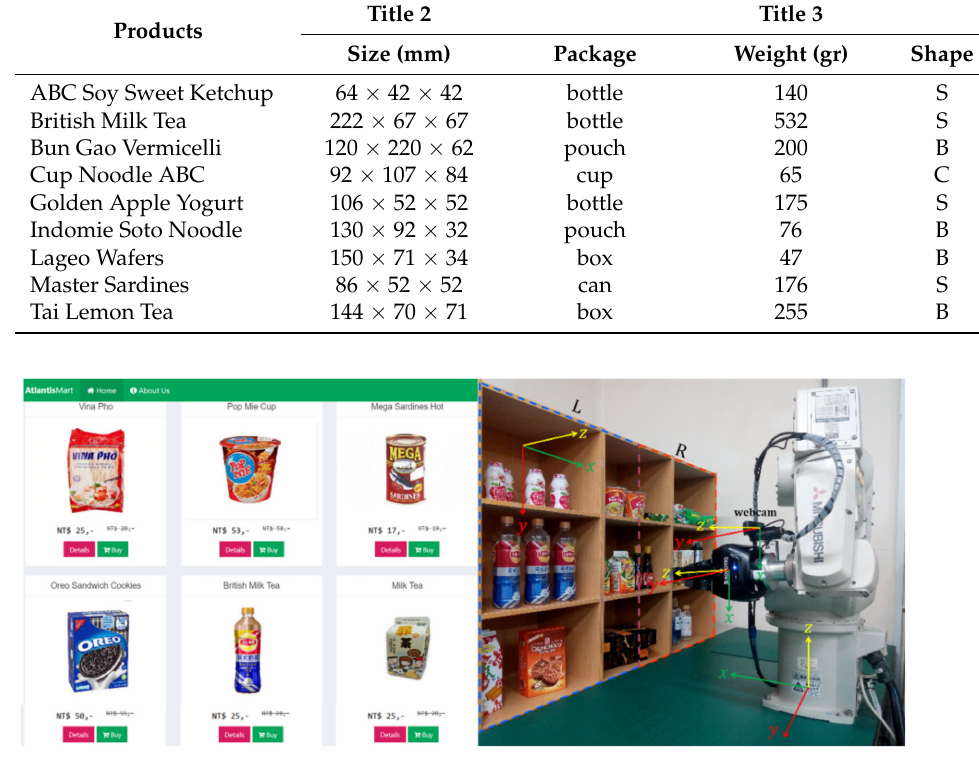
Figure 2. The online ( left ) and offline shop with a 6 degree-of-freedom (6 DOF) robotic manipulator ( right